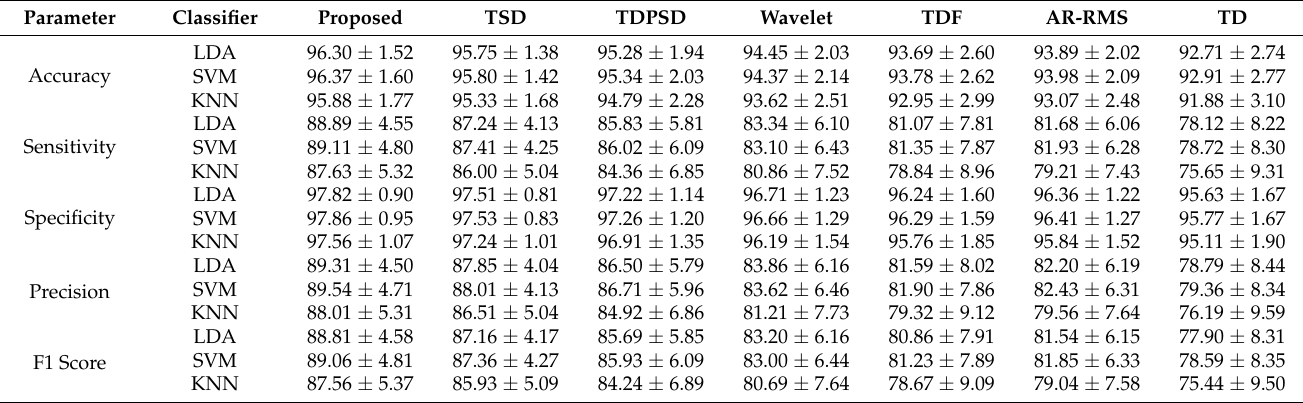
Table A4. The EMG pattern recognition performances when the classifiers are trained and tested with all force